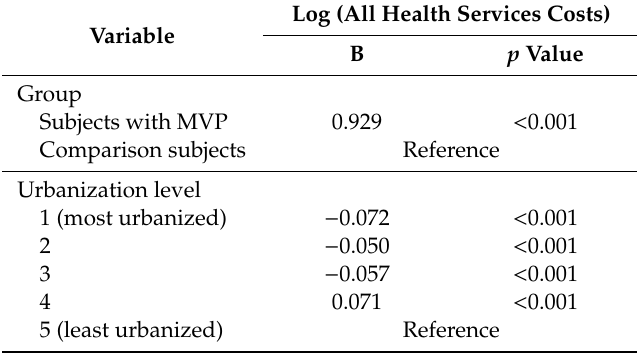
Table 3. Multiple regression analysis results showing adjusted relationships between log-cost of all healthcare services and mitral valve prolapse